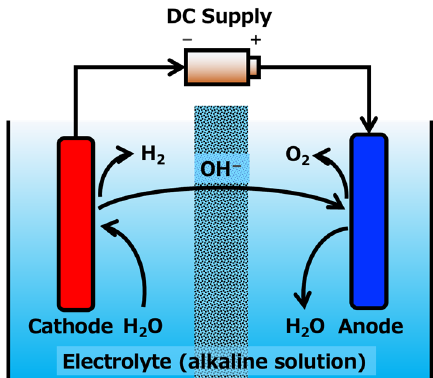
Figure 1. Scheme of a traditional simple electrochemical